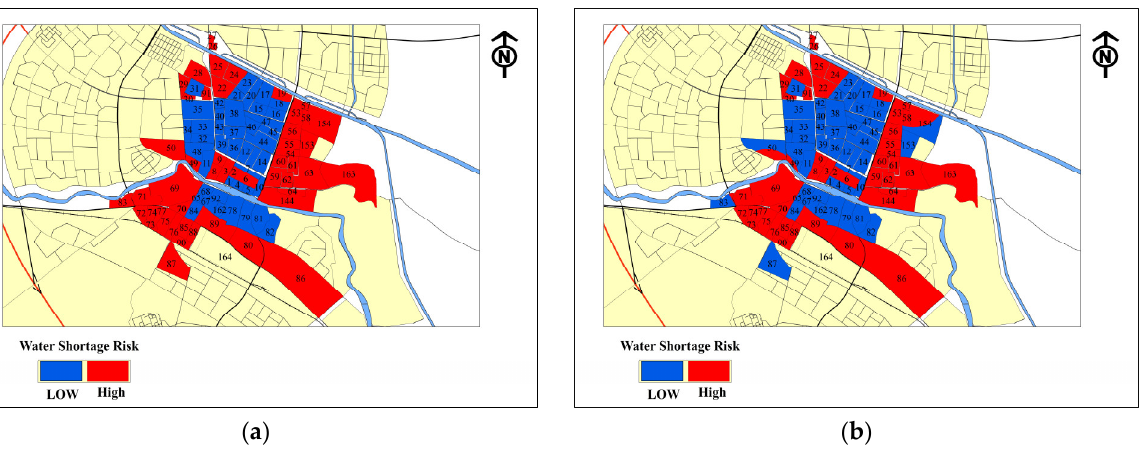
Figure 10. Map ( a ) was created by the direct representative method in GIS, whereas map ( b ) was produced by using the criteria weights gained from SVM algorithm in the WLC technique of GIS. Table 3. Evaluation of classification of map (b) in Figures 6–10 using the corresponding ML algorithm.